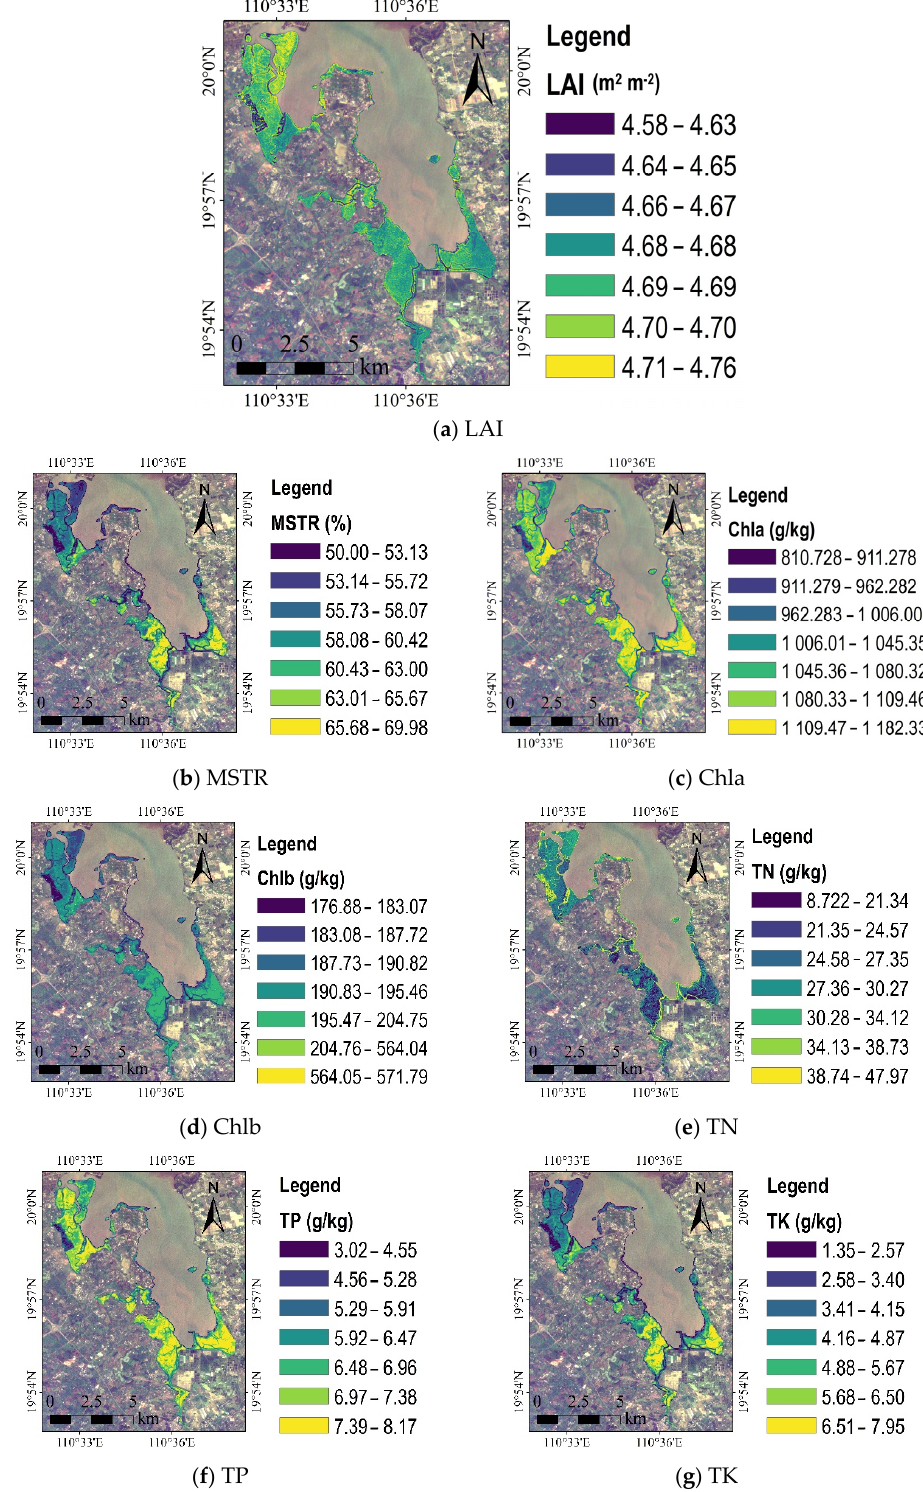
Figure 4. Mapping results of 7 components. ( a ) The distribution of LAI is generally lower than 4.76 m 2 m − 2 ; ( b ) the distribution of MSTR is lower than 70.00 g kg − 1 as a whole; ( c ) the average value of Chla is 1061.19 g kg − 1 ; ( d ) the average value of Chlb is 191.99 g kg − 1 , and its distribution is significantly related to Chla; ( e ) the content of TN is lower than 48.00 g kg − 1 in most areas; ( f ) the average content of TP is 6.76 g kg − 1 ; ( g ) the average content of TK is 4.40 g kg − 1 , and the distribution has a certain correlation with the